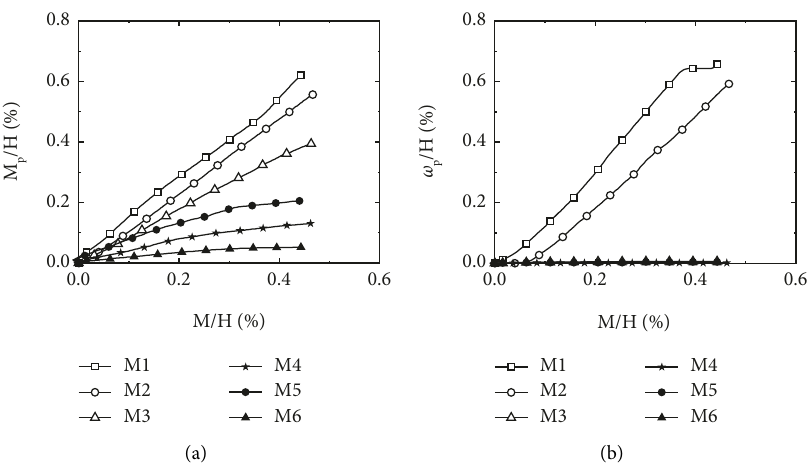
Figure 16: (a) The relationship of the horizontal displacement ( M of the retaining wall.